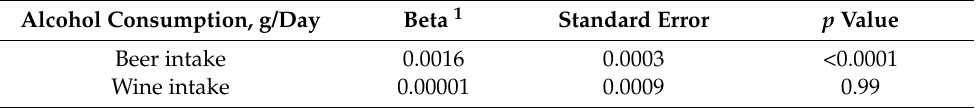
Table 4. HRs (95% CIs) for hyperuricemia according to the tertiles of food group consumption. Food Group Consumption, g/Day Tertile 1 Tertile 2 Tertile 3 Grains and grain products 1.00 0.87 (0.79–0.97) 0.88 (0.80–0.97) Rice 1.00 0.88 (0.81–0.96) 0.87 (0.74–1.02) Vegetables 1.00 0.96 (0.87–1.06) 0.85 (0.77–0.94) Fruits 1.00 1.07 (0.97–1.18) 1.01 (0.91–1.12) Meat and meat products 1.00 0.95 (0.86–1.06) 0.98 (0.88–1.08) Fish and shellfish 1.00 0.96 (0.87–1.06) 0.96 (0.87–1.06) Milk and dairy products 1.00